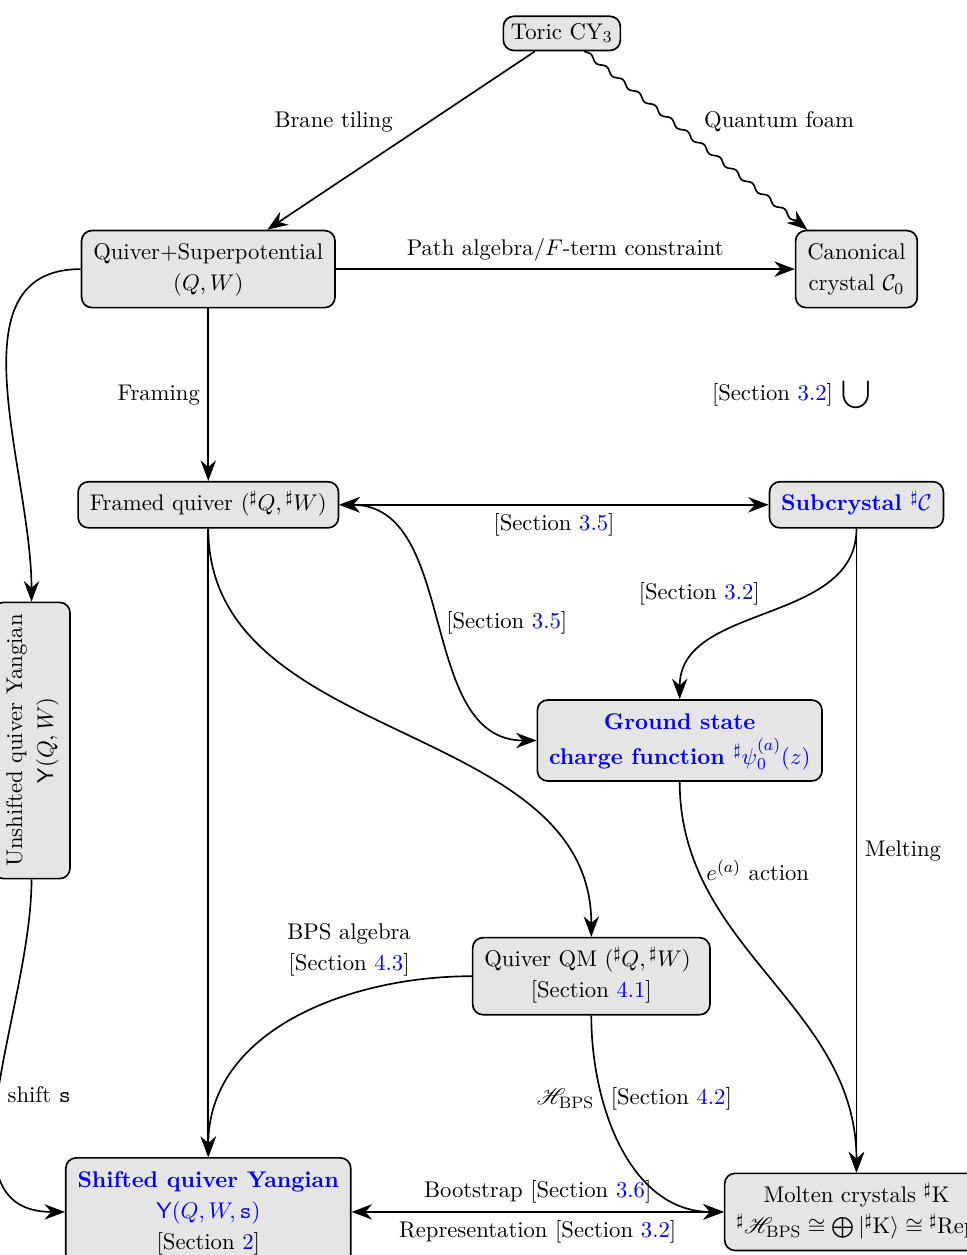
Figure 1 . Interrelations of various concepts discussed in this paper. Those colored in blue are new concepts introduced in this